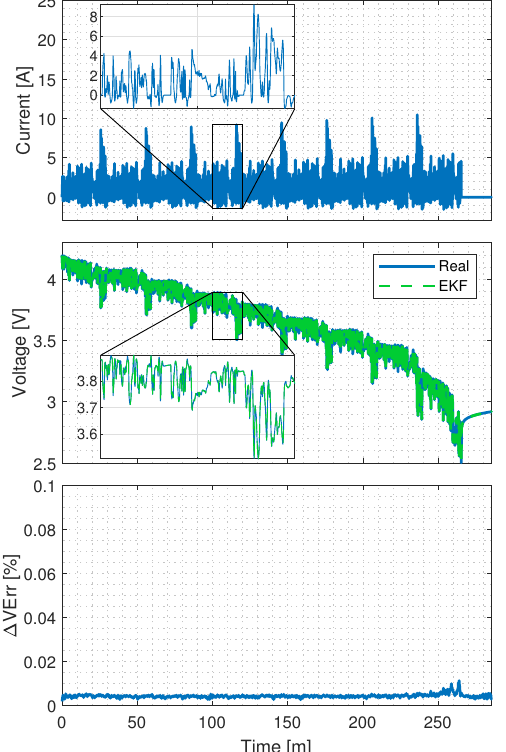
Figure 9. Samsung 500 cycle, type “C”. Comparison between the output voltage estimated by the GO-EKF and real measurement.